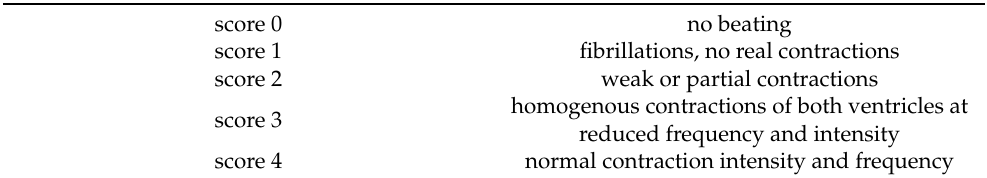
postoperative day